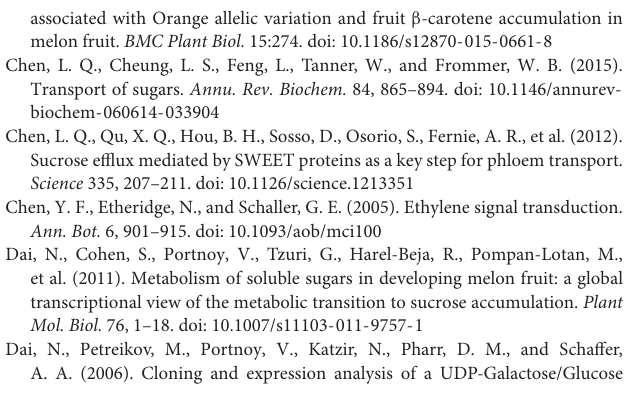
Supplementary Table 5 | Correlation statistics of DEGs and DAMs related to sugar and organic acids metabolism. The data were screened from the two comparison groups of AFS2 vs. BFS2 and AFS3 vs. BFS3. Supplementary Table 6 | The expression change in candidate genes related to soluble sugar and organic acid metabolism. The expression was based on the fold-change, and the data of BFS1 were used as the